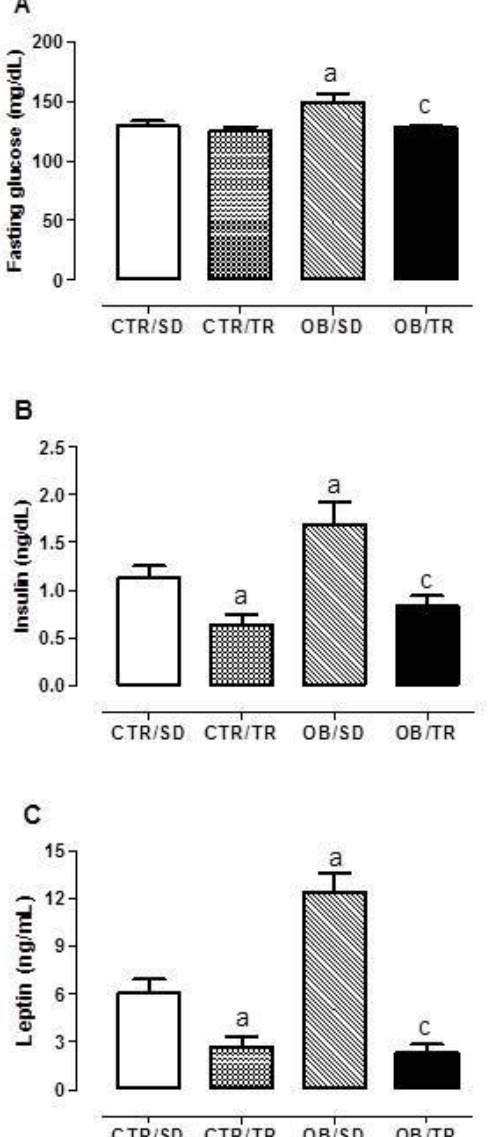
Figure 2. Fasting glucose (panel A), insulin (panel B) and leptin (panel C) from control sedentary (CTR/SD), control trained (CTR/ TR), obese sedentary (OB/SD) and obese trained (OB/TR). Data are mean±SEM. ANOVA two-way, Bonferroni post test ( P <0.05). a dif- ferent from CTR/SD, c different from